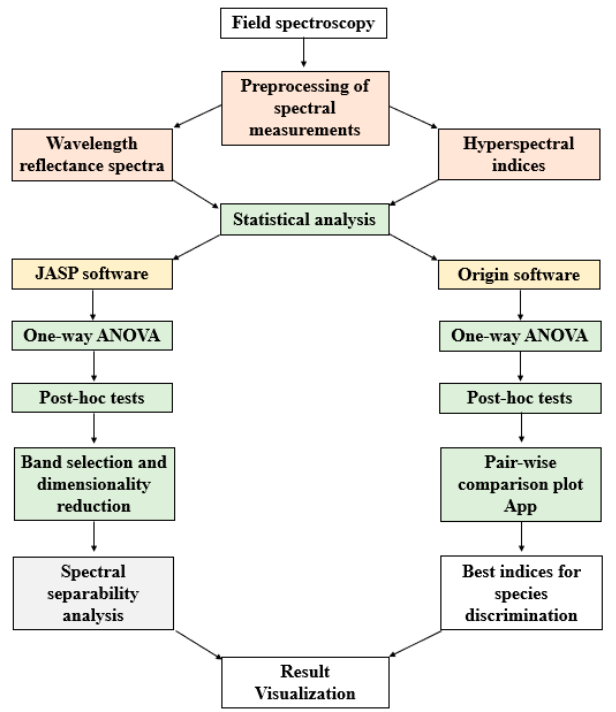
Figure 4. Flowchart of the main methodology adopted.